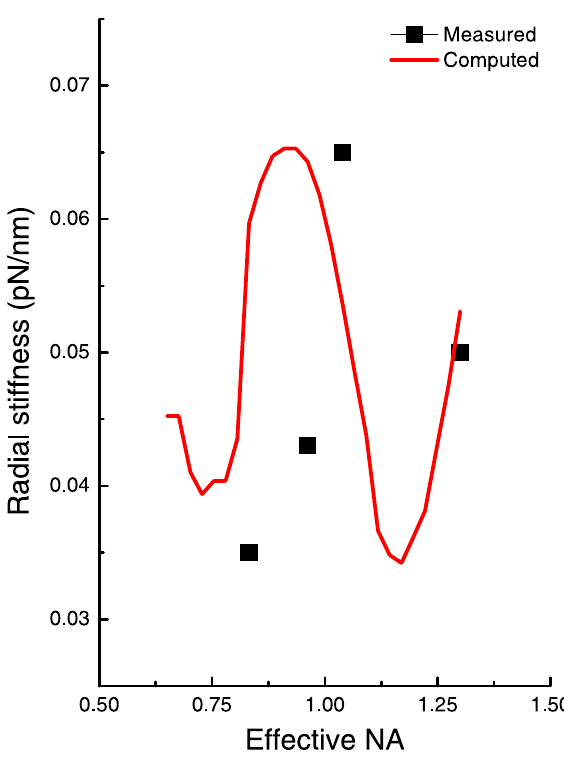
Figure 5. Radial trap stiffness computed using the Nieminen toolbox (see refs. [ 38,39 ] ). The line denotes the computed results while the solid squares are measured values. Our computations used the following parameters: the refractive index of our polystyrene beads was 1.57; the beads were dispersed in water whose refractive index was taken to be 1.326; the wavelength of the trapping laser was 1.064 m m.